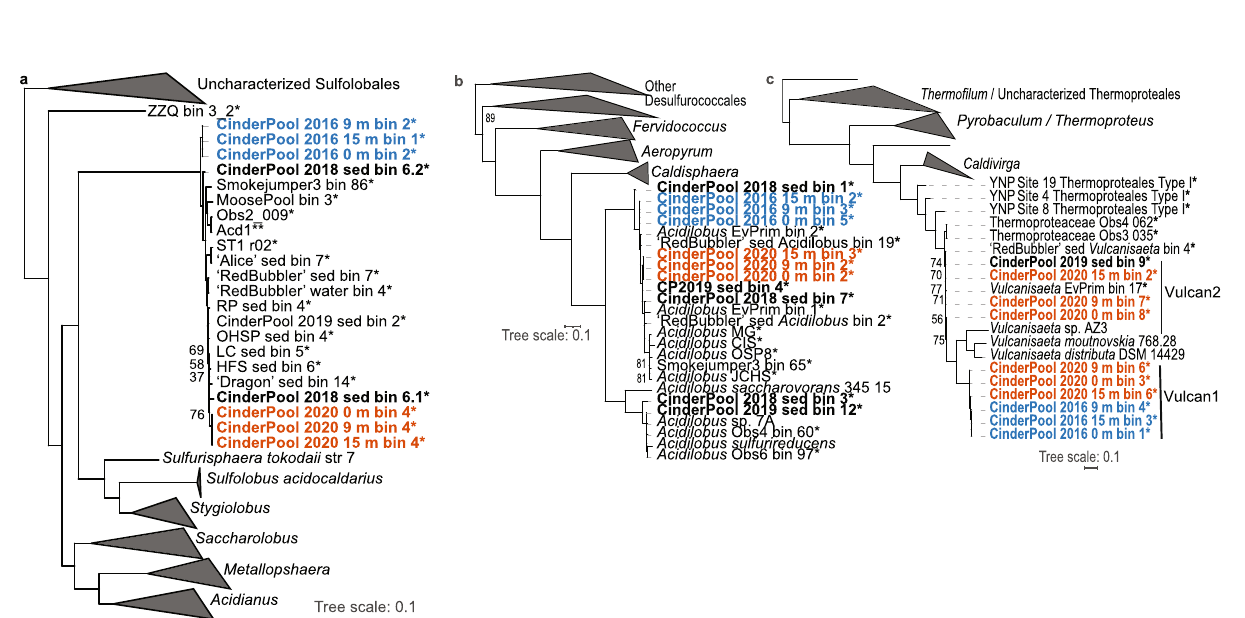
Fig. 4 Phylogenomic analysis of metagenome-assembled genomes (MAGs) recovered from Cinder Pool (CP) in depth-resolved samples taken in 2016 and 2020. Maximum-Likelihood phylogenomic trees are shown for the three dominant populations present in both the 2016 and 2020 CP water communities: a Uncultured Sulfolobales, b Acidilobus , and c Vulcanisaeta . A MAG corresponding to a second Vulcanisaeta strain was present in the 2020 water samples and is differentiated by those detected in both sampling years by the “ Vulcan2 ” designation. Phylogenies were constructed from 103 universal archaeal housekeeping single-copy genes (e.g., ribosomal proteins, RNA polymerase subunits, etc.), and available reference genomes from other Thermoproteales. MAGs highlighted in orange are those from the 2020 CP water communities, with the depth given next to the name, while those highlighted in blue were recovered from the 2016 water communities. Bolded, black text indicates MAGs recovered from CP sediments in 2018 and 2019 via our other studies. Asterisks indicate MAGs recovered from YNP springs (as part of this study, or other studies). Bootstrap values were evaluated with 1000 replicates and only those <90 are shown. Scale bars next to individual trees show the expected number of substitutions per site.